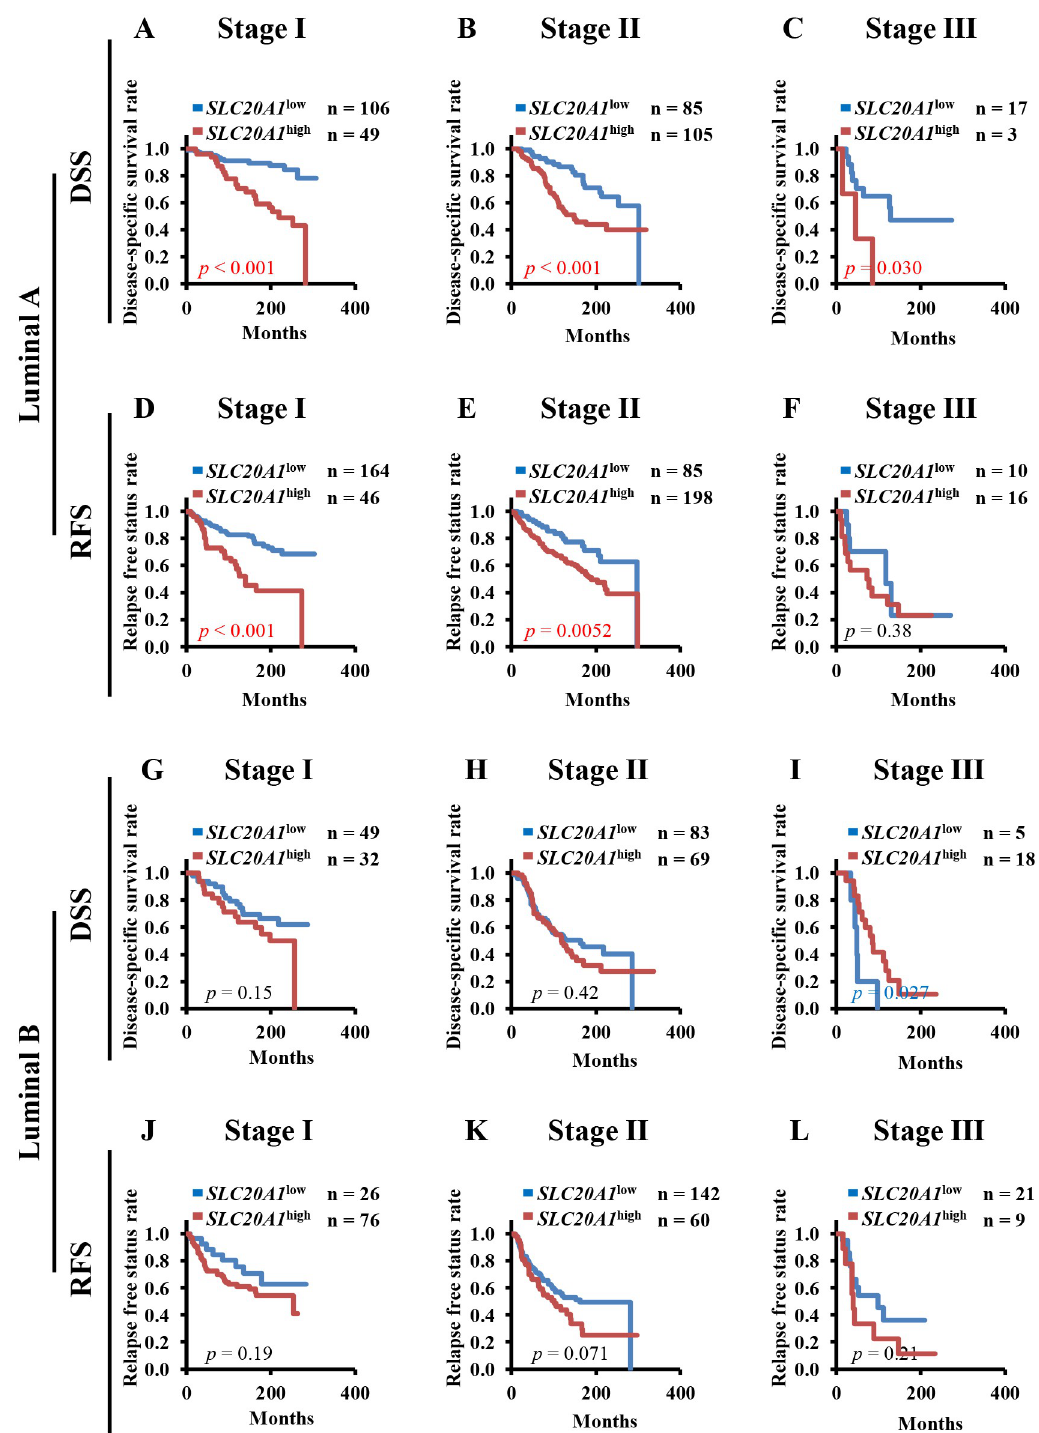
Fig 2. Patients with high solute carrier family 20 member 1 (SLC20A1) expression ( SLC20A1 high ) have poorer outcomes from early-stage luminal A breast cancer. (A-F) Kaplan-Meier analyses comparing disease-specific survival (DSS) and relapse- free status (RFS) in patients with luminal A breast cancer between the SLC20A1 high and SLC20A1 low groups. (A) DSS in tumor stage I. (B) DSS in tumor stage II. (C) DSS in tumor stage III. (D) RFS in tumor stage I. (E) RFS in tumor stage II. (F) RFS in tumor stage III. (G-L) Kaplan-Meier analyses comparing DSS and RFS in patients with luminal B breast cancer between the SLC20A1 high and SLC20A1 low groups. (G) DSS in tumor stage I. (H) DSS in tumor stage II. (I) DSS in tumor stage III. (J) RFS in tumor stage I. (K) RFS in tumor stage II. (L) RFS in tumor stage